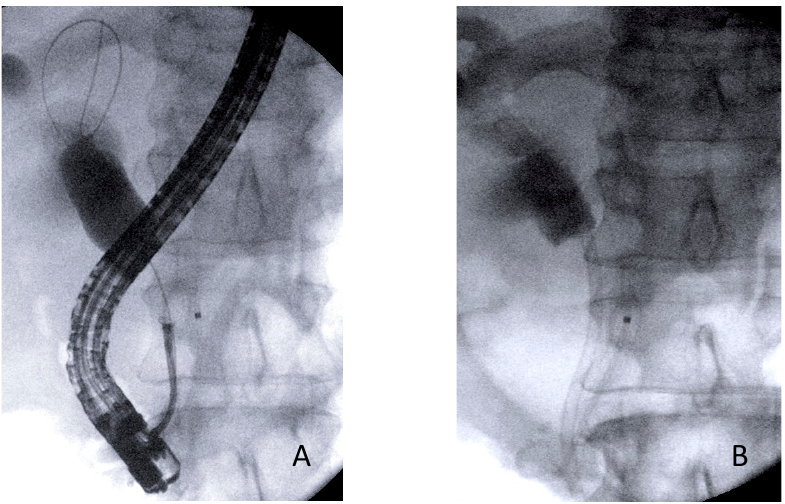
A B Figure 3. ( A ) Forceps biopsy during ERCP in a patient with medio-proximal biliary stricture. ( B ) At the end of the procedure, biliary drainage was performed with the placement of a plastic stent. Table 3. Diagnostic yield of ERCP with brushing/biopsy and EUS-FNA/B according to site of biliary